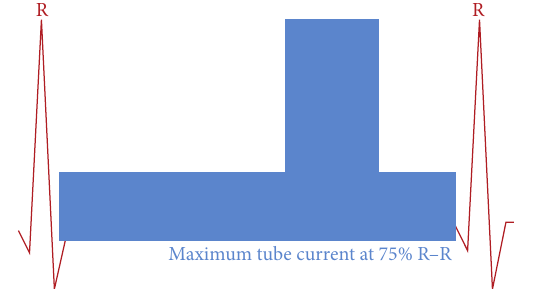
Figure 2: Complete phase window with tube modulation, 76 × 39 mm (300 × 300 DPI).